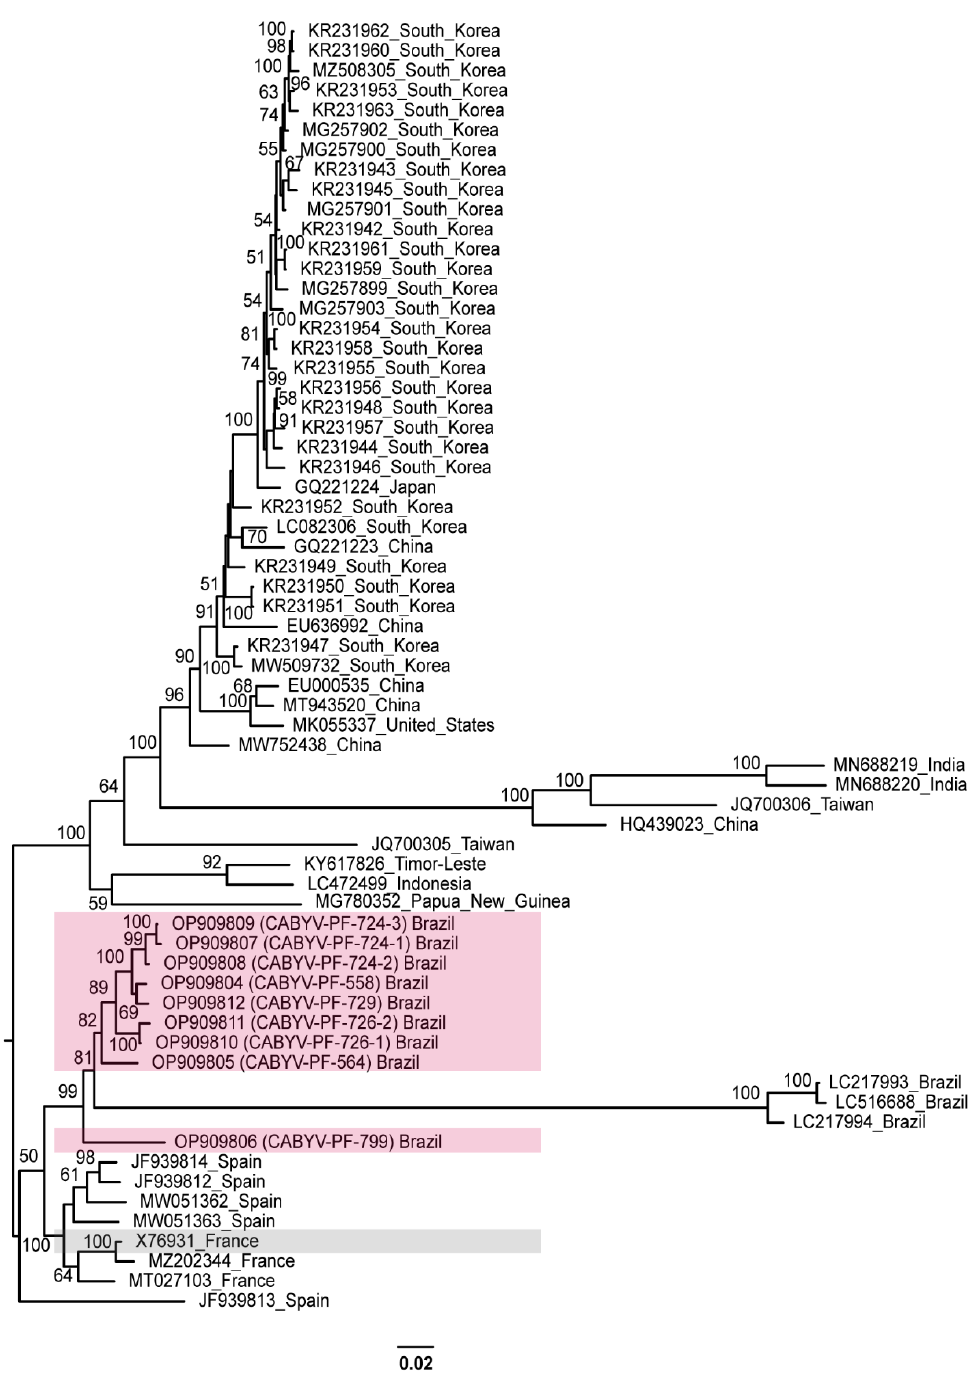
Figure 3. Midpoint-rooted phylogenetic tree of the complete nucleotide sequences of the CABYV sequences obtained in this study and of other isolates available in GenBank. Pink and gray boxes highlight CABYV-PF isolates and CABYV reference sequence, respectively. Phylogenetic trees were reconstructed using maximum likelihood in RAxML-NG v. 1.0.3 software using a MUSCLE alignment generated in the Geneious Prime ® 2022.1.1. Bootstrap support values >50% for 1000 replicates are displayed on or near the branches. The bar indicates 0.02 nucleotide substitutions per site.